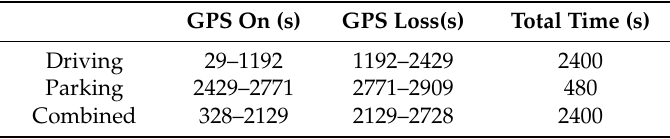
Figure 4. Experiment 1: Vehicle driving velocity. Table 3. Time allocations of different independent stage.